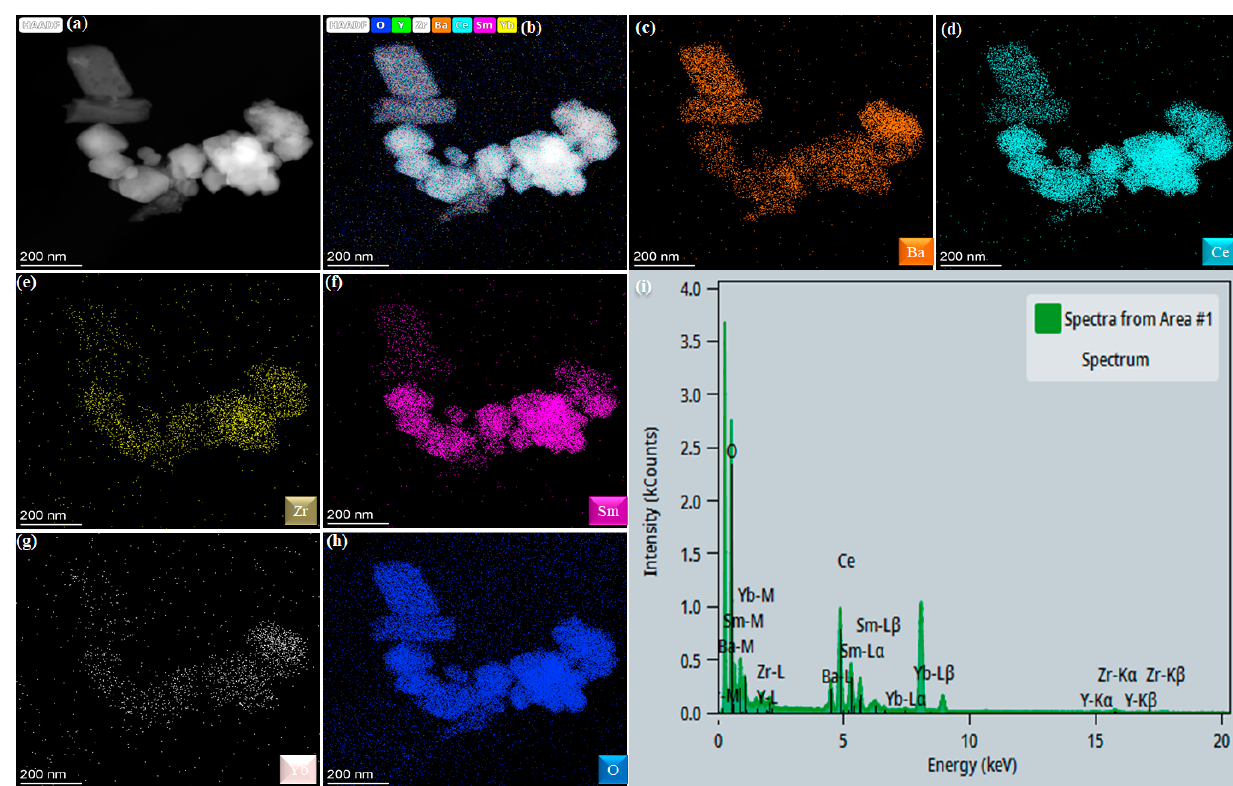
Figure 3. ( a ) HAADF-STEM image of the prepared BCZYYb-SDC heterostructure composite pow- der at high resolution. ( b – h ) Individual element mapping of each component presents in BCZYYB- SDC heterostructure composite, respectively, and ( i ) EDS spectrum of BCZYYB-SDC heterostruc-